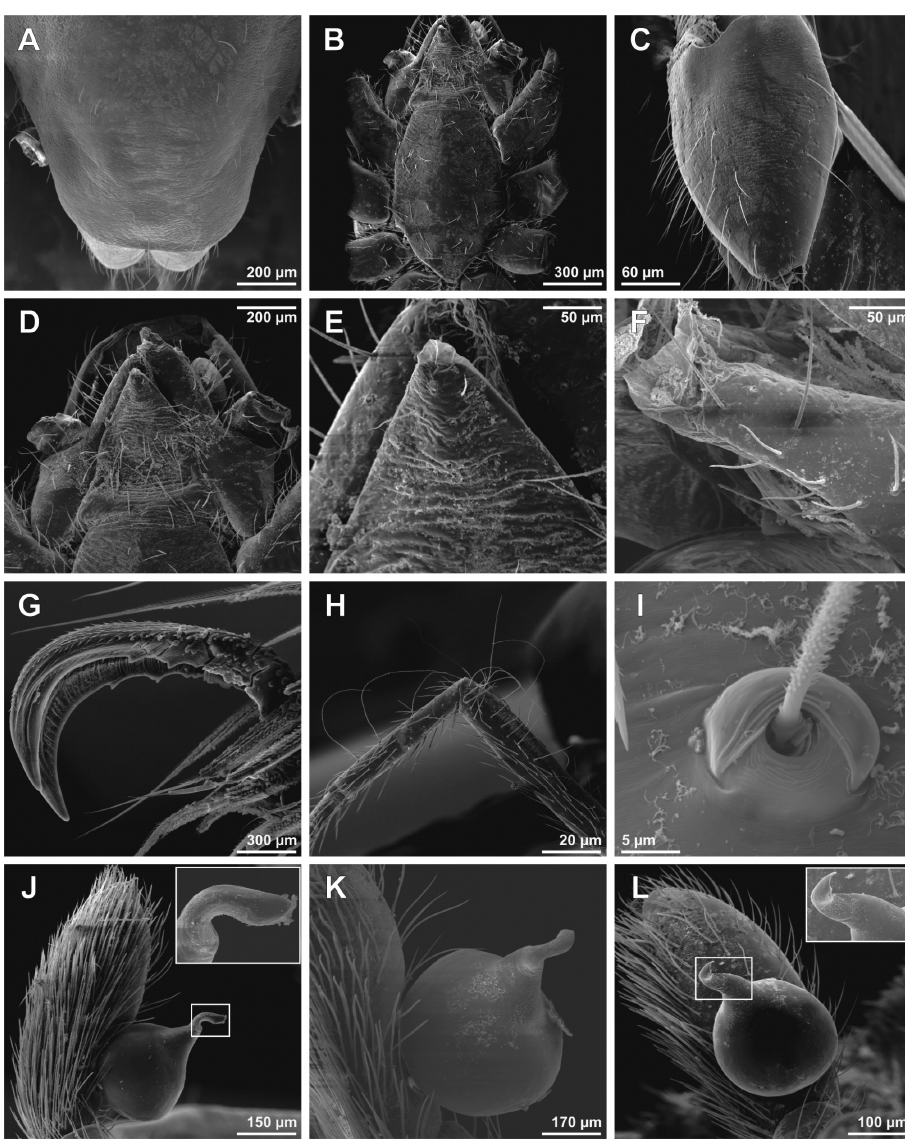
Figure 14. SEM images of Carajas paraua sp. n., male from type locality. A carapace, ocular area, dorsal view B carapace, ventral view C left chelicerae, prolateral view D mouthparts, ventral view E labium, distal area, ventral view F labium, distal area, prolateral view G paired claws on right leg IV, prolateral view H right tibiae and metatarsus I showing long trichobotria, prolateral view I tricobothria base on right leg I, dorsal view J pedipalp, prolateral view (inset: detail of embolus) K bulb, dorsal view L same,ventral view (inset: detail of